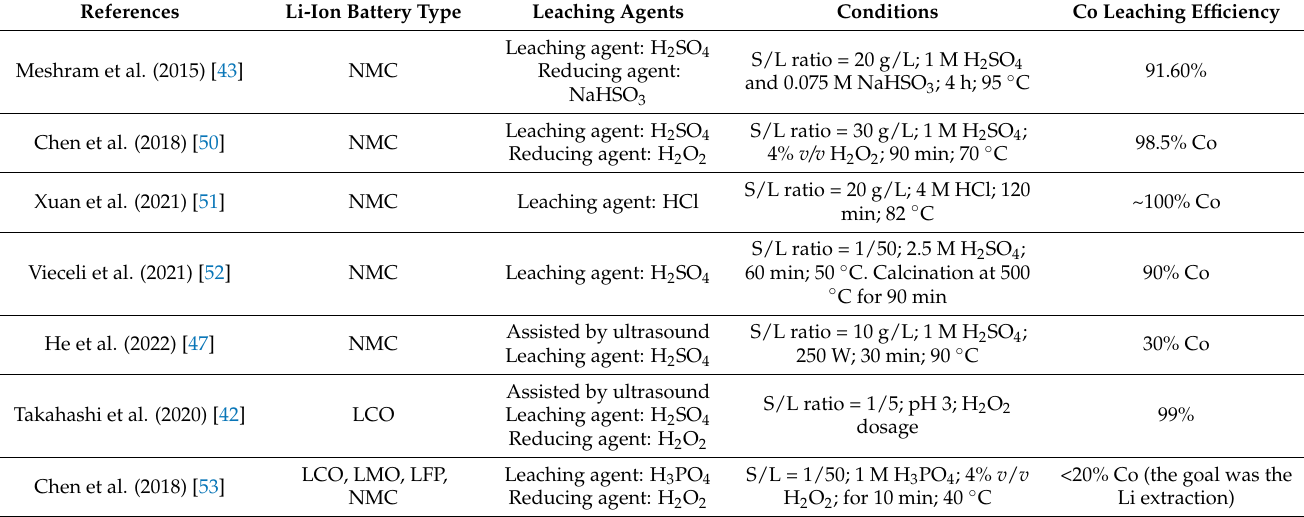
Table 2. A literature review of Li-ion battery leaching by inorganic